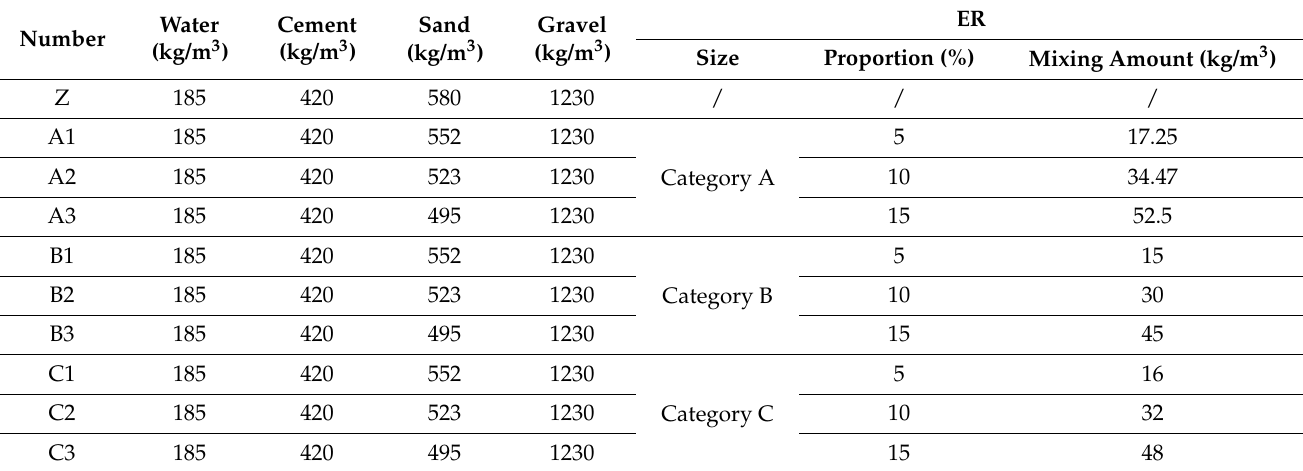
Table 1. Proportion of ER concrete mix with various epoxy plastic board dose and particle